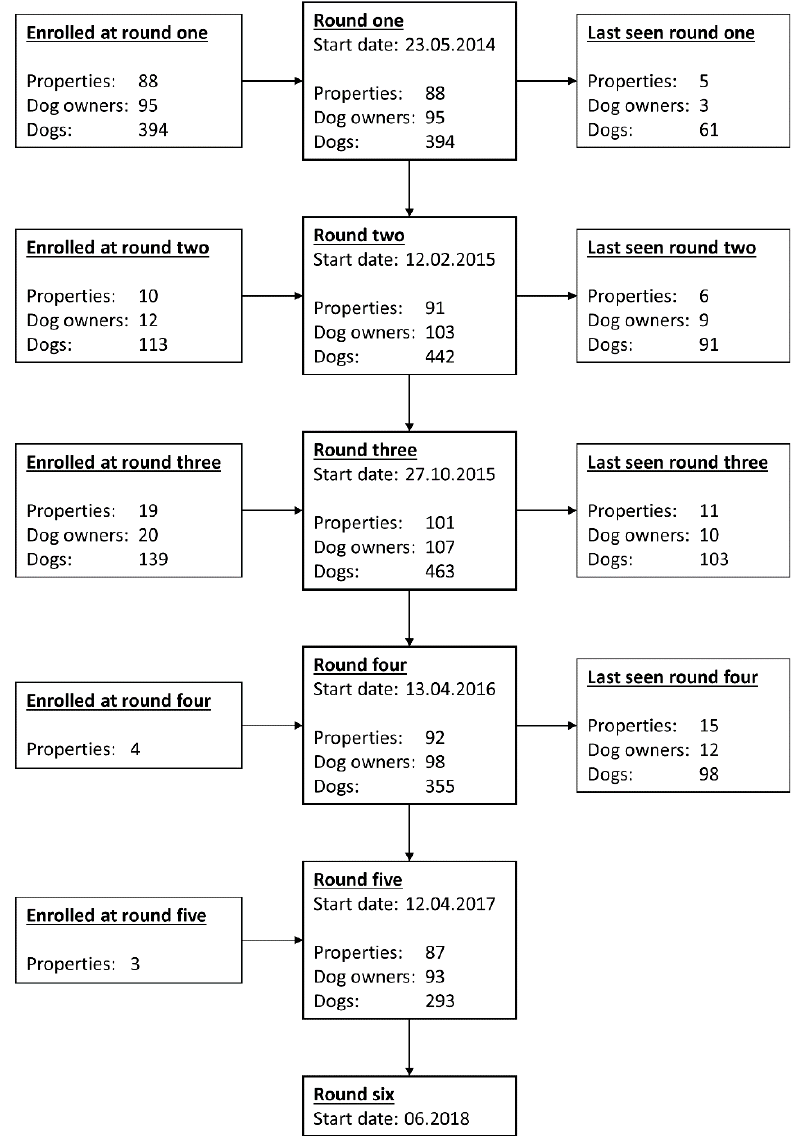
Figure 1. Flowchart showing the start dates of each data collection round as well as the number of farms, dog owners and dogs enrolled in TeamMate up to and including the fifth round of farm visits. Additionally, 14 properties, 16 dog owners and 68 dogs missed at least one round of data collection. Note that data for the sixth data collection round were not yet available at the time of writing. This figure was previously published by the authors [4] and is licensed for re-use under the Creative Commons Attribution 4.0 International licence.